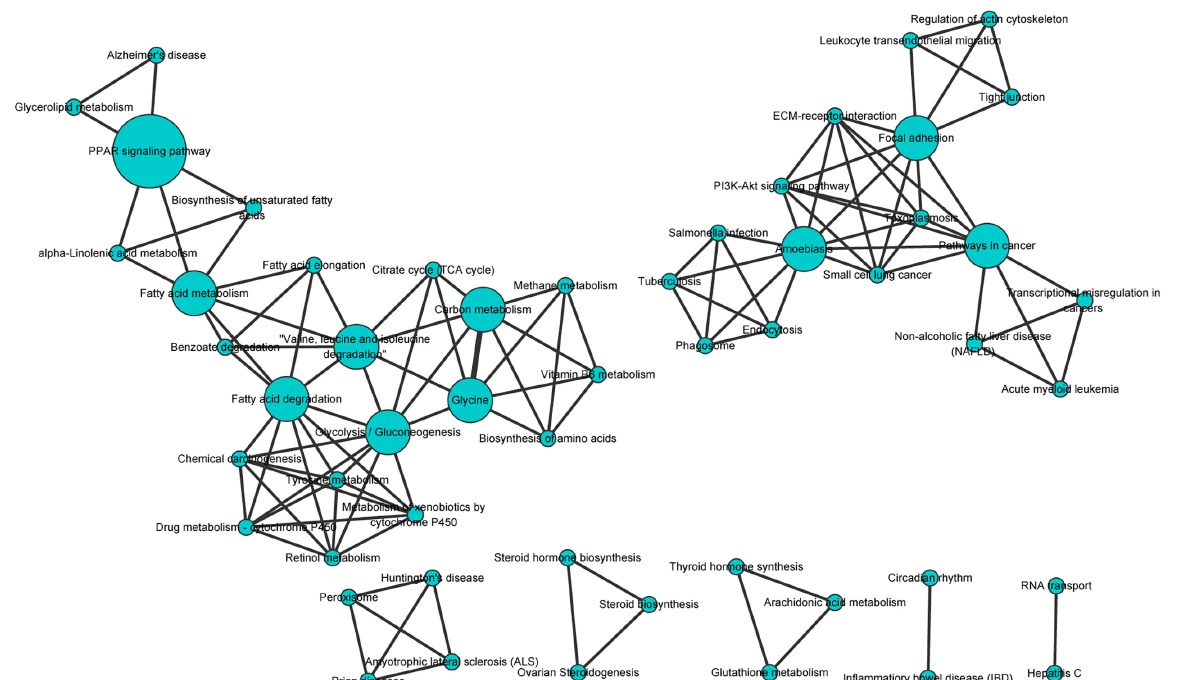
Fig 5. KEGG map of differentially expressed genes by the Cytoscape software. The size of circle indicates the number of unigenes, the line thickness indicates the number of overlapping unigenes.